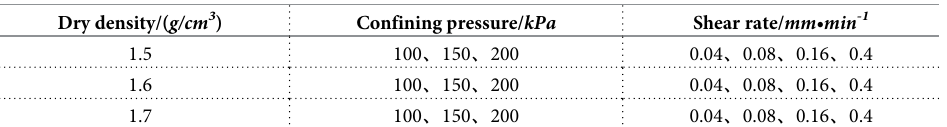
Table 2. Test design